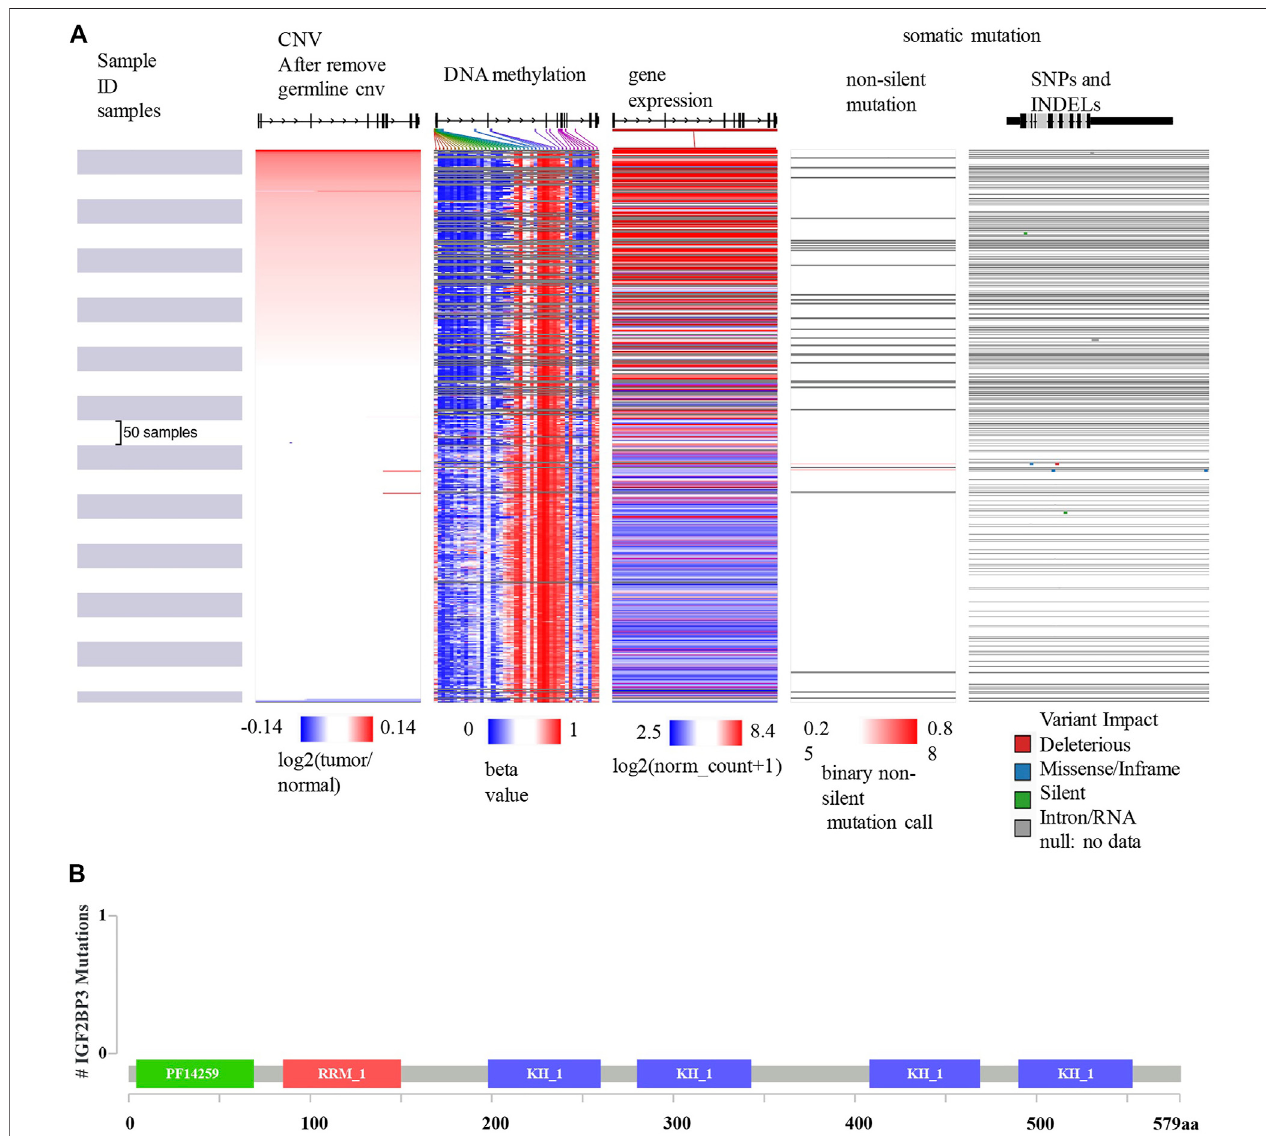
FIGURE 7 | Mutation, CNV, and methylation analysis of IGF2BP3 in gliomas. (A) Heatmap showing the correlations between IGF2BP3 mRNA and somatic mutations, CNV, and methylation in gliomas via UCSCXena. (B) Correlation between IGF2BP3 mRNA and somatic mutation in gliomas via the cBioportal for Cancer